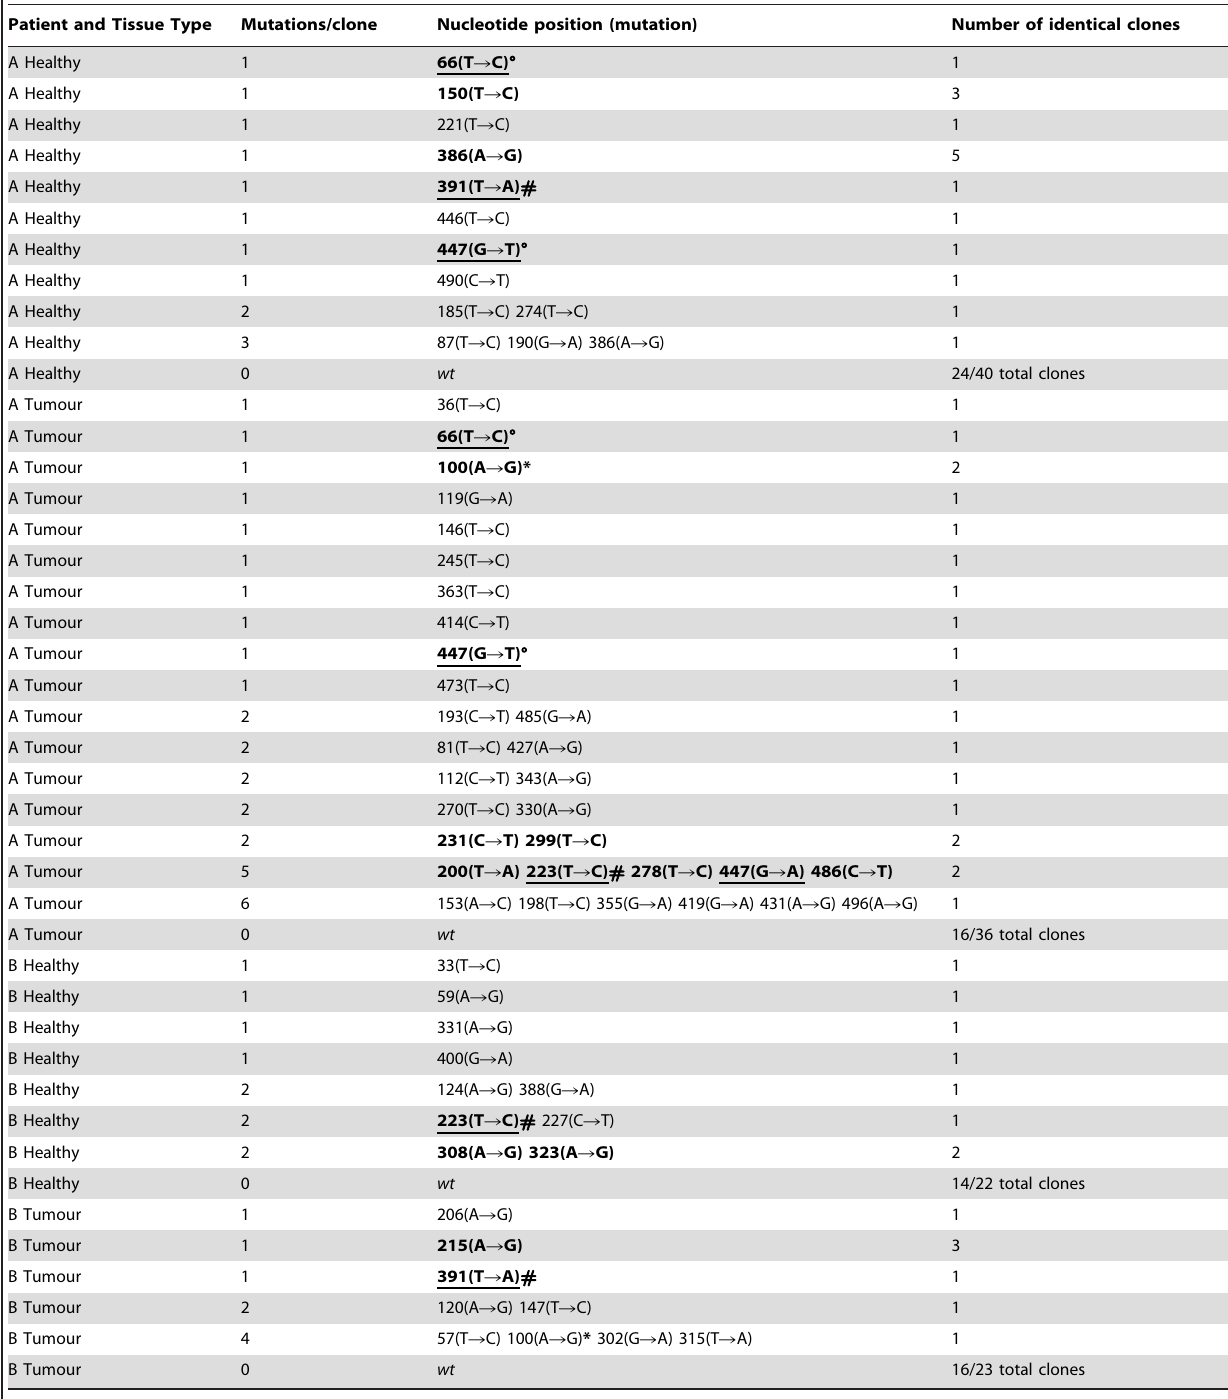
Table 1. Mutations in HPRT transcripts in tumour and nearby healthy